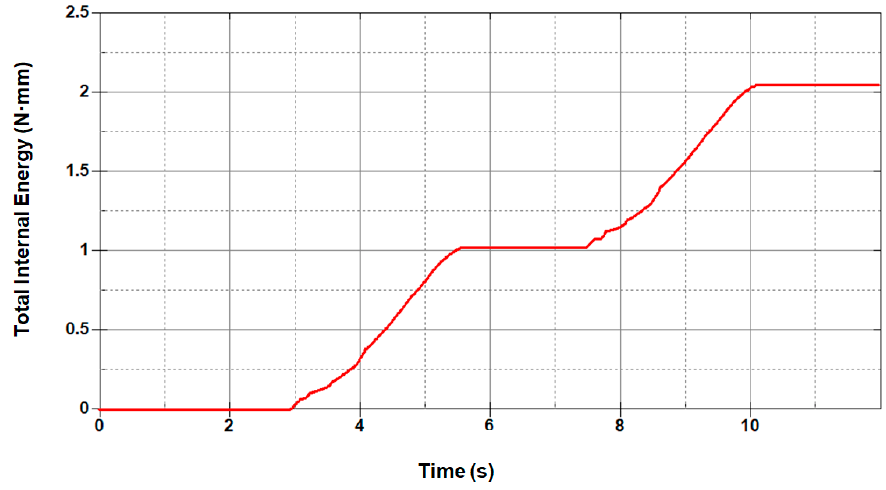
Figure 11. Total internal energy in both sheets being cut versus time.